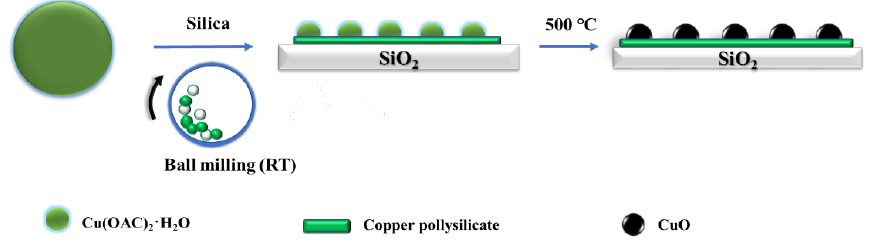
Scheme 1. Simplified diagrammatic evolution of W% Cu-A-BM catalysts.